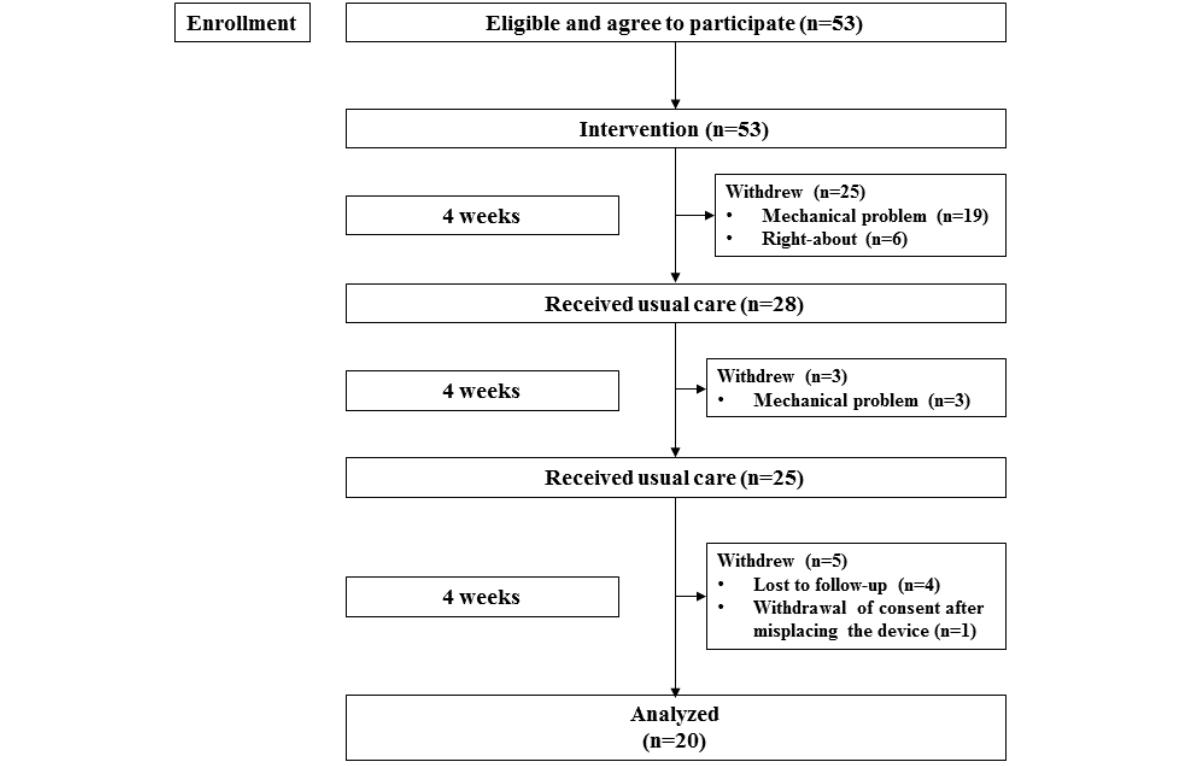
Figure 2. Flowchart of patient enrollment and the reasons for dropout. Right-about: withdrawal of consent within 24 hours; lost to follow-up: participant neither picked up the counseling call nor provided any